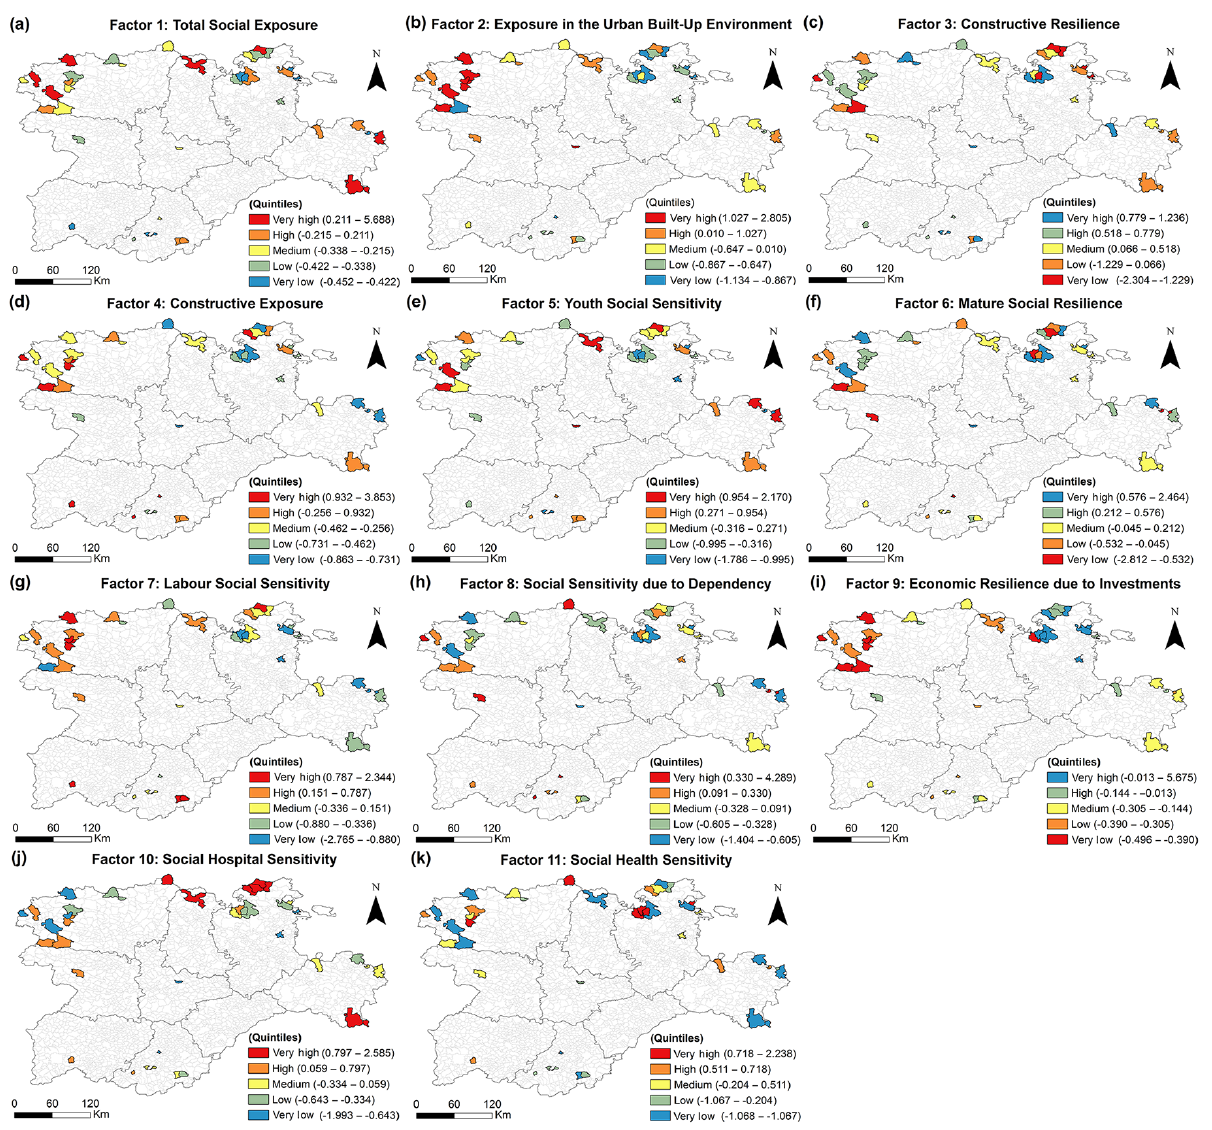
Figure 4. Factor scores for identified vulnerability factors. For exposure and sensitivity factors, very high categories are coloured in red, while, for resilience factors, very high categories are coloured in blue. Source: municipal boundaries (available online: http://www.ign.es; accessed on 5 December